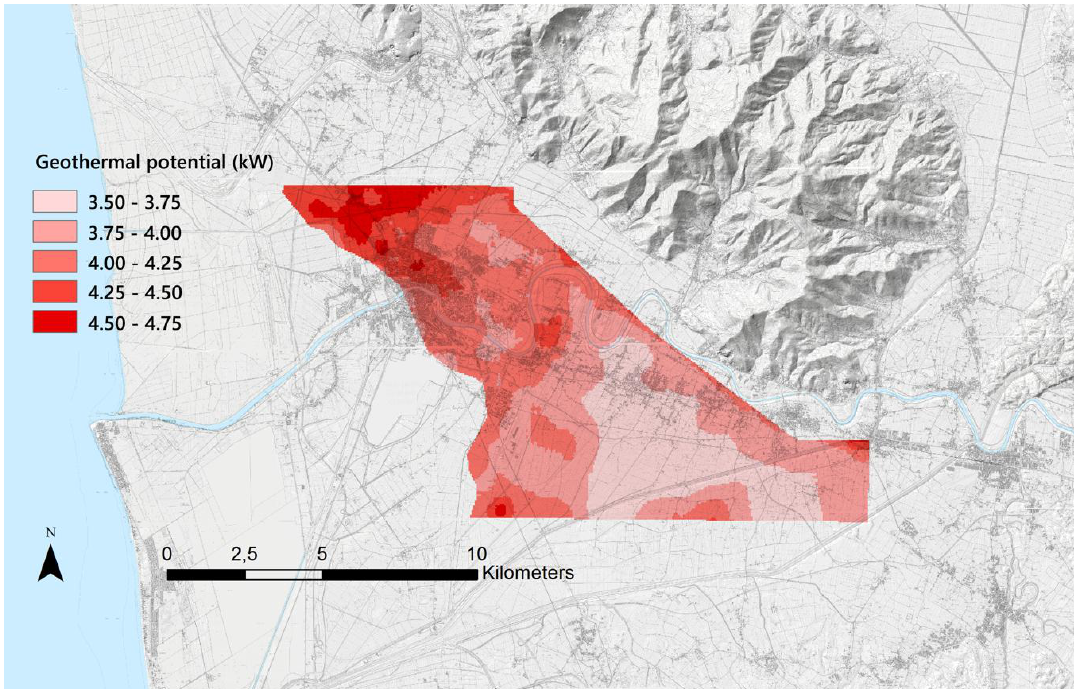
Figure 15. Geothermal potential (kW) for heating-only by geothermal closed-loop systems (for 1 standard vertical BHE). Depth: 100 m. The calculation follows [46] QBHE = [a (T0 − Tlim) λ L t’c]/[−0.619 t’c log (u’s) + (0.532 t’c − 0.962) log (u’c) − 0.455 t’c − 1.619 + πλRb]; where QBHE